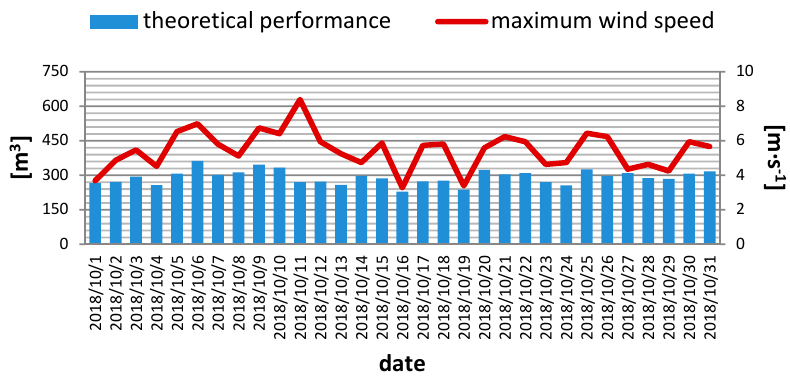
Figure 11. E ffi ciency of the pulverization unit of the aerator in October. Figure 11. Efficiency of the pulverization unit of the aerator in October.